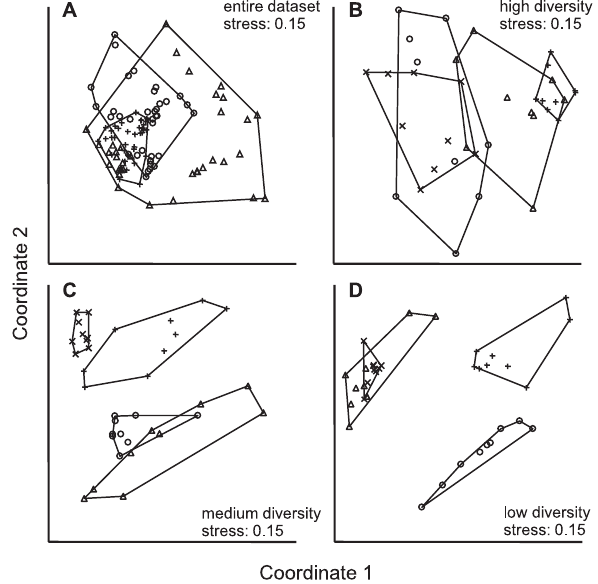
Figure 1. Non-metric multidimensional scalings (nMDS) of the 16S rRNA genes community profiles. Panel (A) shows the entire dataset. Panel (B) shows the high diversity treatment, panel (C) the medium and panel (D) the low diversity treatments. In panel (A), outlines indicated the diversity treatments: + high diversity, # medium diversity and D low diversity. In panel B, C and D the outlines indicate the treatments: # labile/young, + labile/old, x recalcitrant/young and D recalcitrant/old.